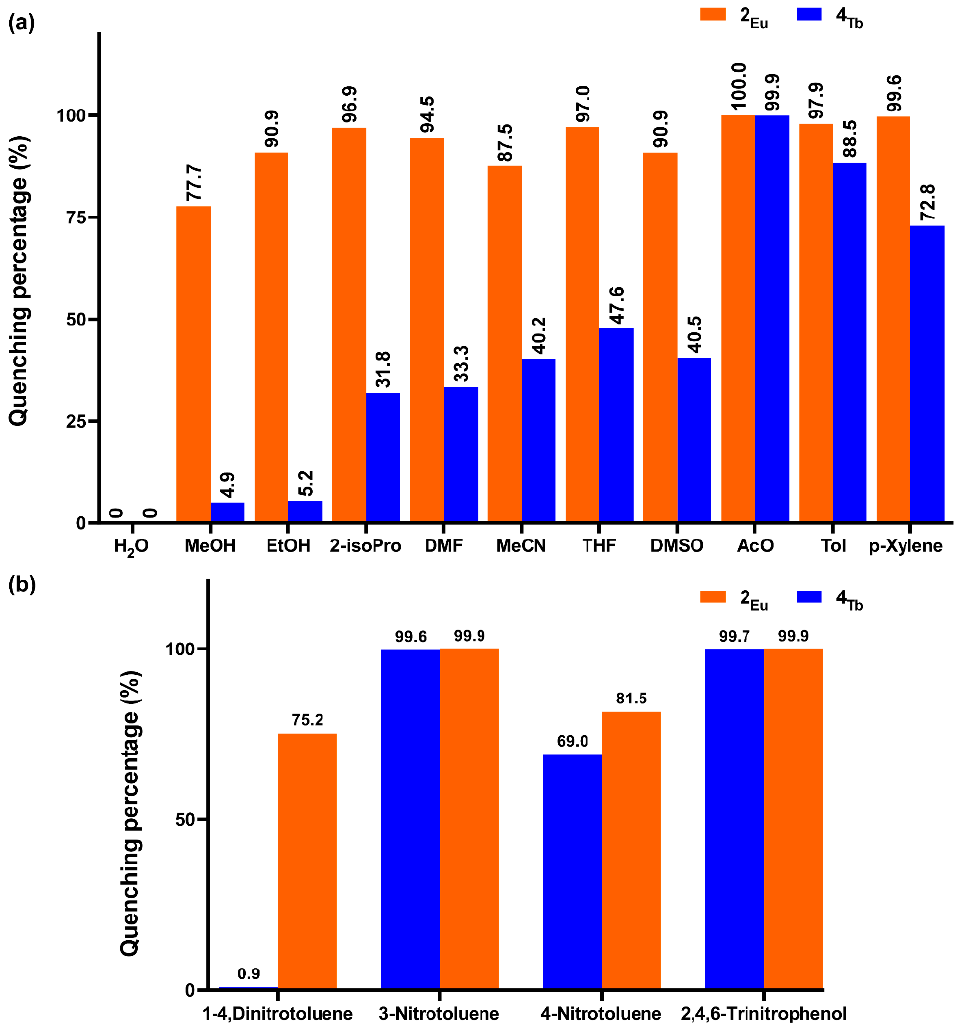
Figure 6. Bar charts showing the PL sensing results in the form of quenching percentages with respect to the blank compound@H 2 O dispersion for various: ( a ) solvents and ( b ) nitroaromatic molecules. According to the literature, the luminescence quenching of CPs by small molecules, such as the herein studied solvents, may be caused by different phenomena, involving collapse of the framework, guest exchange, host-guest interaction, competing absorption, etc., [76]. The ligand-centered excitation band describes a distinct shape due to the different antenna effect efficiency, but shares the presence of remarkable absorption intensity in the 275–350 nm range, which is largely overlapped with the absorption band of the